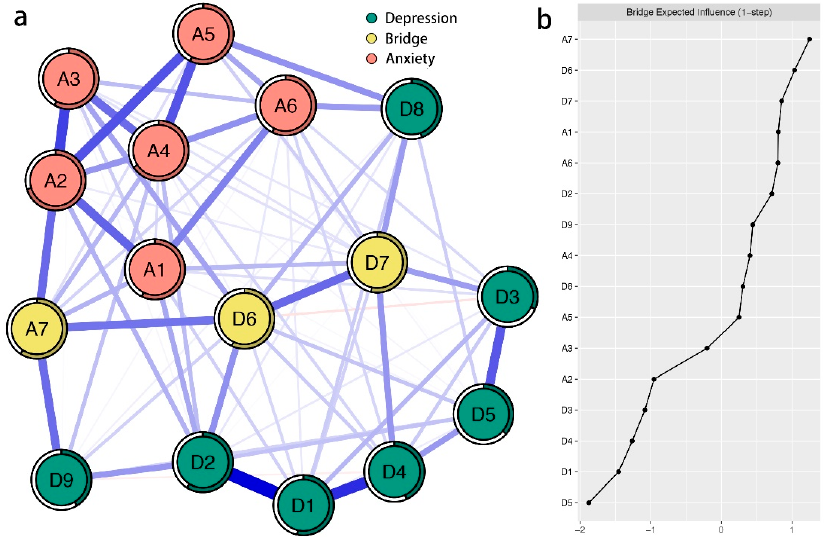
Figure 2. Network structure of depression and anxiety symptoms showing bridge symptoms in tinnitus sufferers. ( a ) Blue edges represent positive correlations, red edges represent negative correlations, and the thickness of the edge reflects the magnitude of the correlation. The circles around nodes depict their predictability. ( b ) Centrality plot depicting the bridge expected influence of each symptom in the network (z-score). D1 = Anhedonia; D2 = Feeling depressed or hopeless; D3 = Sleep problems; D4 = Energy loss; D5 = Appetite changes; D6 = Feeling of worthlessness; D7 = Trouble concentrating; D8 = Psychomotor issues; D9 = Suicidal ideation; A1 = Feeling nervous or anxious; A2 = Unable to control worry; A3 = Excessive worry; A4 = Relaxation difficulty; A5 = Too restless to sit still; A6 = Easily annoyed or irritable; A7 = Afraid something awful might happen. 3.4. Flow Network of Suicidal Ideation with Depression and Anxiety Symptoms in Tinnitus Sufferers Figure 3 delineated a flow chart showing how depression symptom D9 “Suicidal ide- ation” was connected to all other symptoms in the current network. There were nine symptoms directly related to D9 “Suicidal ideation” and six symptoms indirectly related to it. The direct relations between D9 “Suicidal ideation” and anxiety symptom A7 “Afraid something awful might happen” and depression symptom D2 “Feeling depressed or hopeless” were the strongest. Additionally, the predictability of depression symptom D9 “Suicidal ideation” indicated that 41% of its variance could be explained by its neighbor- ing nodes (Table 2).